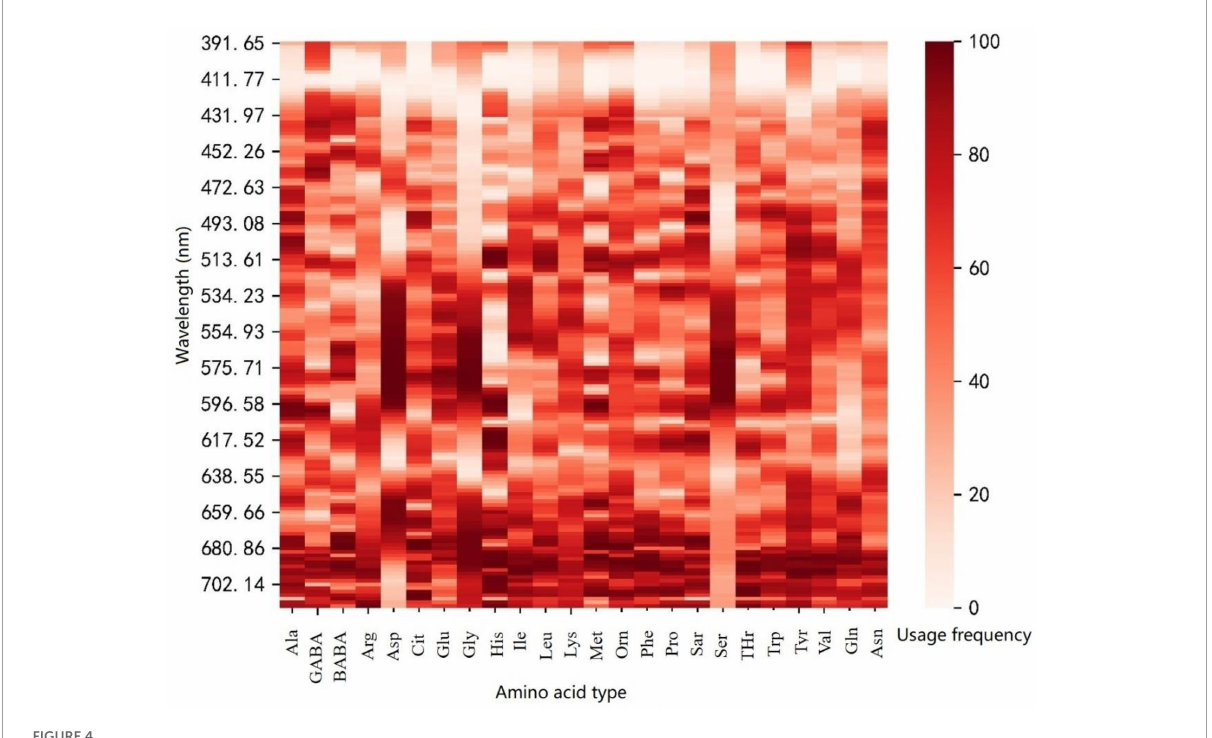
FIGURE4 The usage frequency of each band in 100 times of